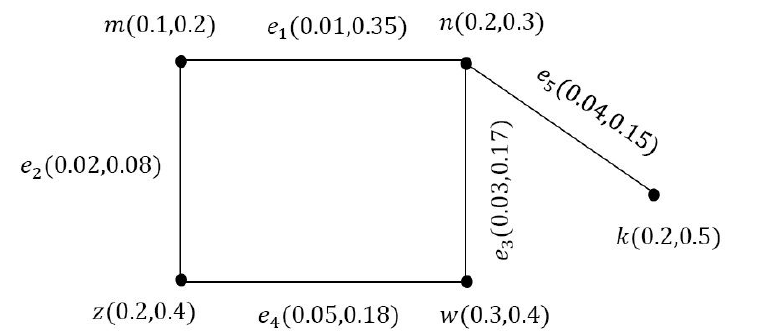
Figure 8. Open edge neighborhood set in product vague graph ζ